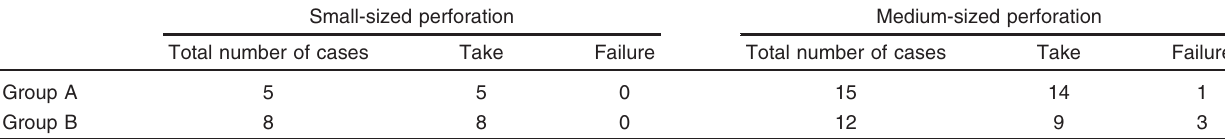
Table 4 The take rate in different